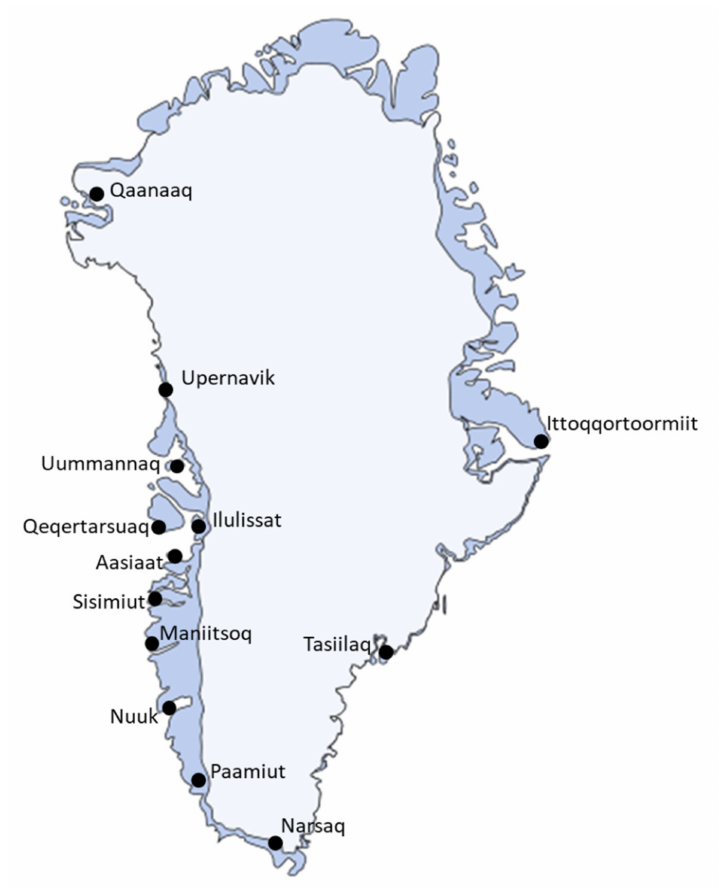
Figure 1. Map of Greenland with the collection